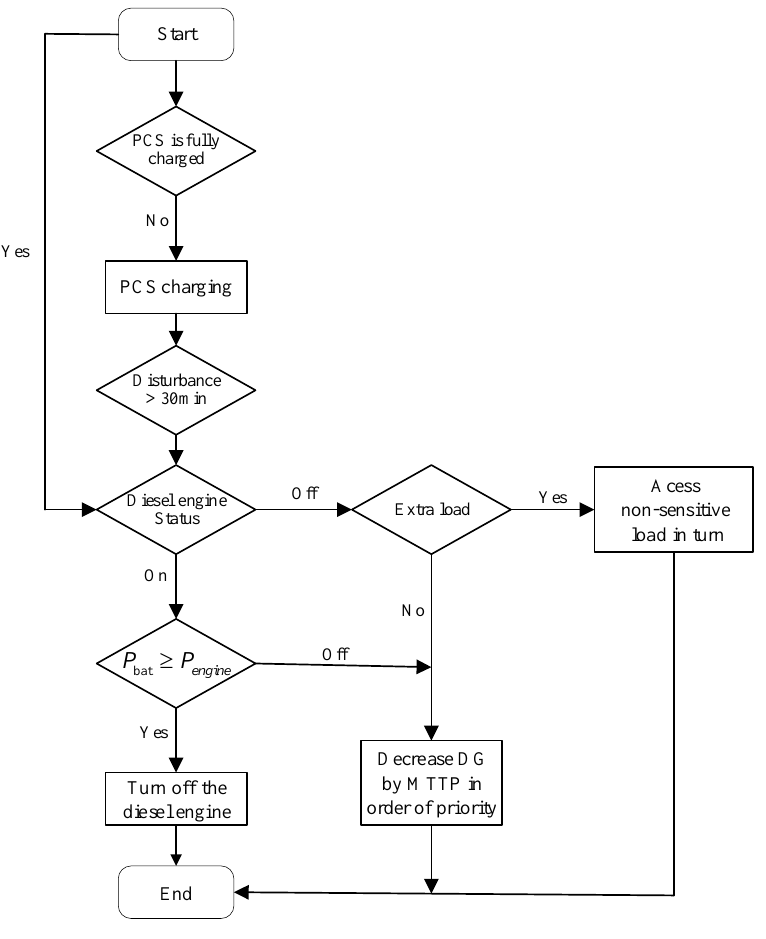
Figure 2. BH zone frequency control strategy.